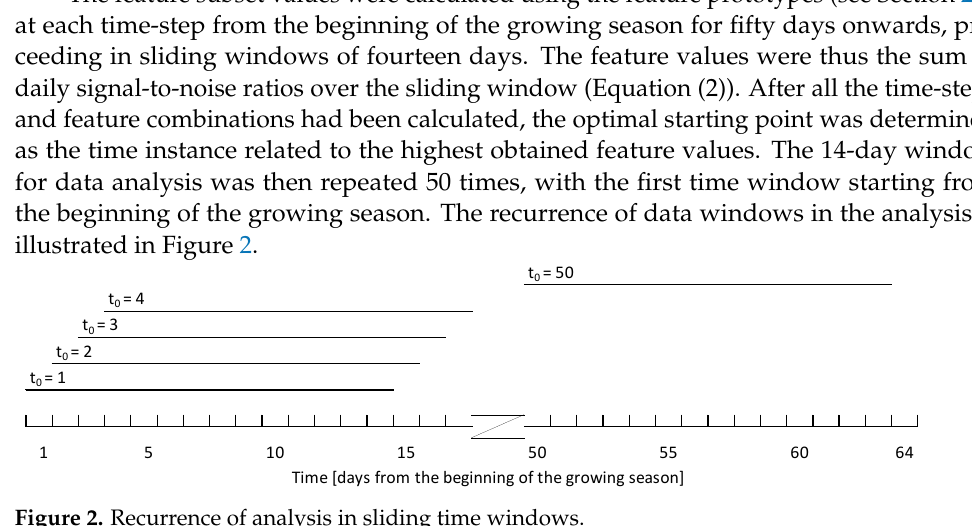
Figure 1. Analysis procedure for meteorological data to identify time instance of optimal information content concerning forecasting the severity of net blotch occurrence.